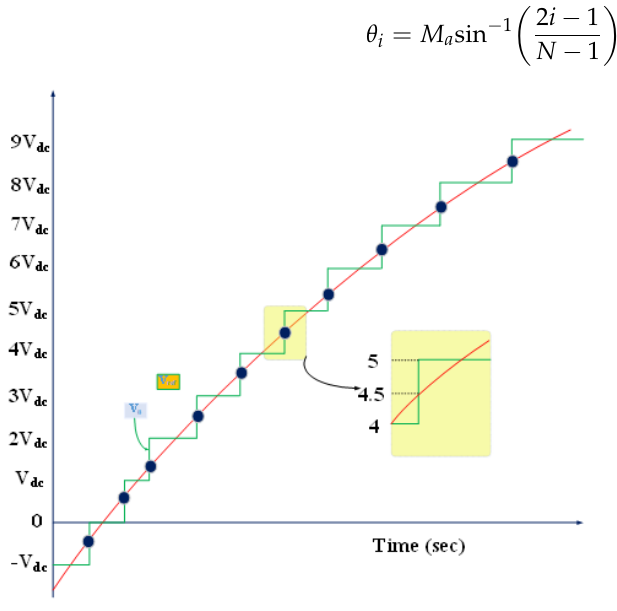
Figure 3. Nearest level modulation.